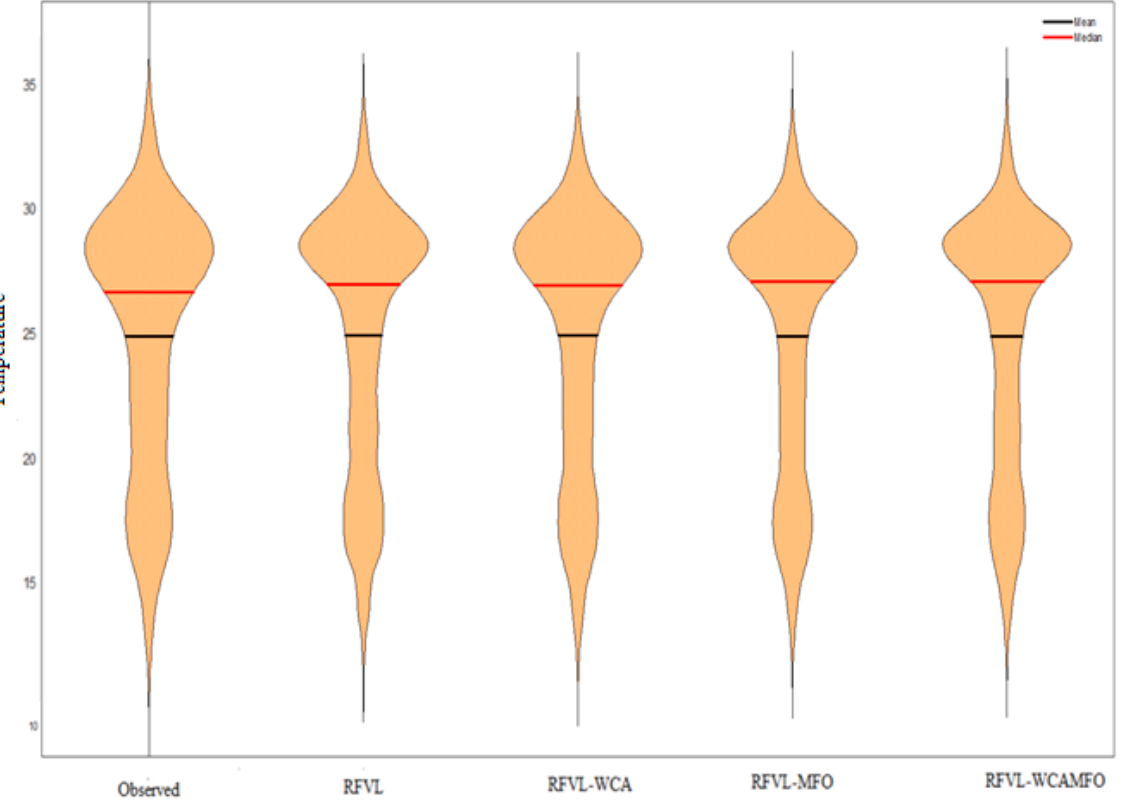
Figure 9. Violin Charts estimated temperature by different RVFL-based models in the test period for daily time scale.